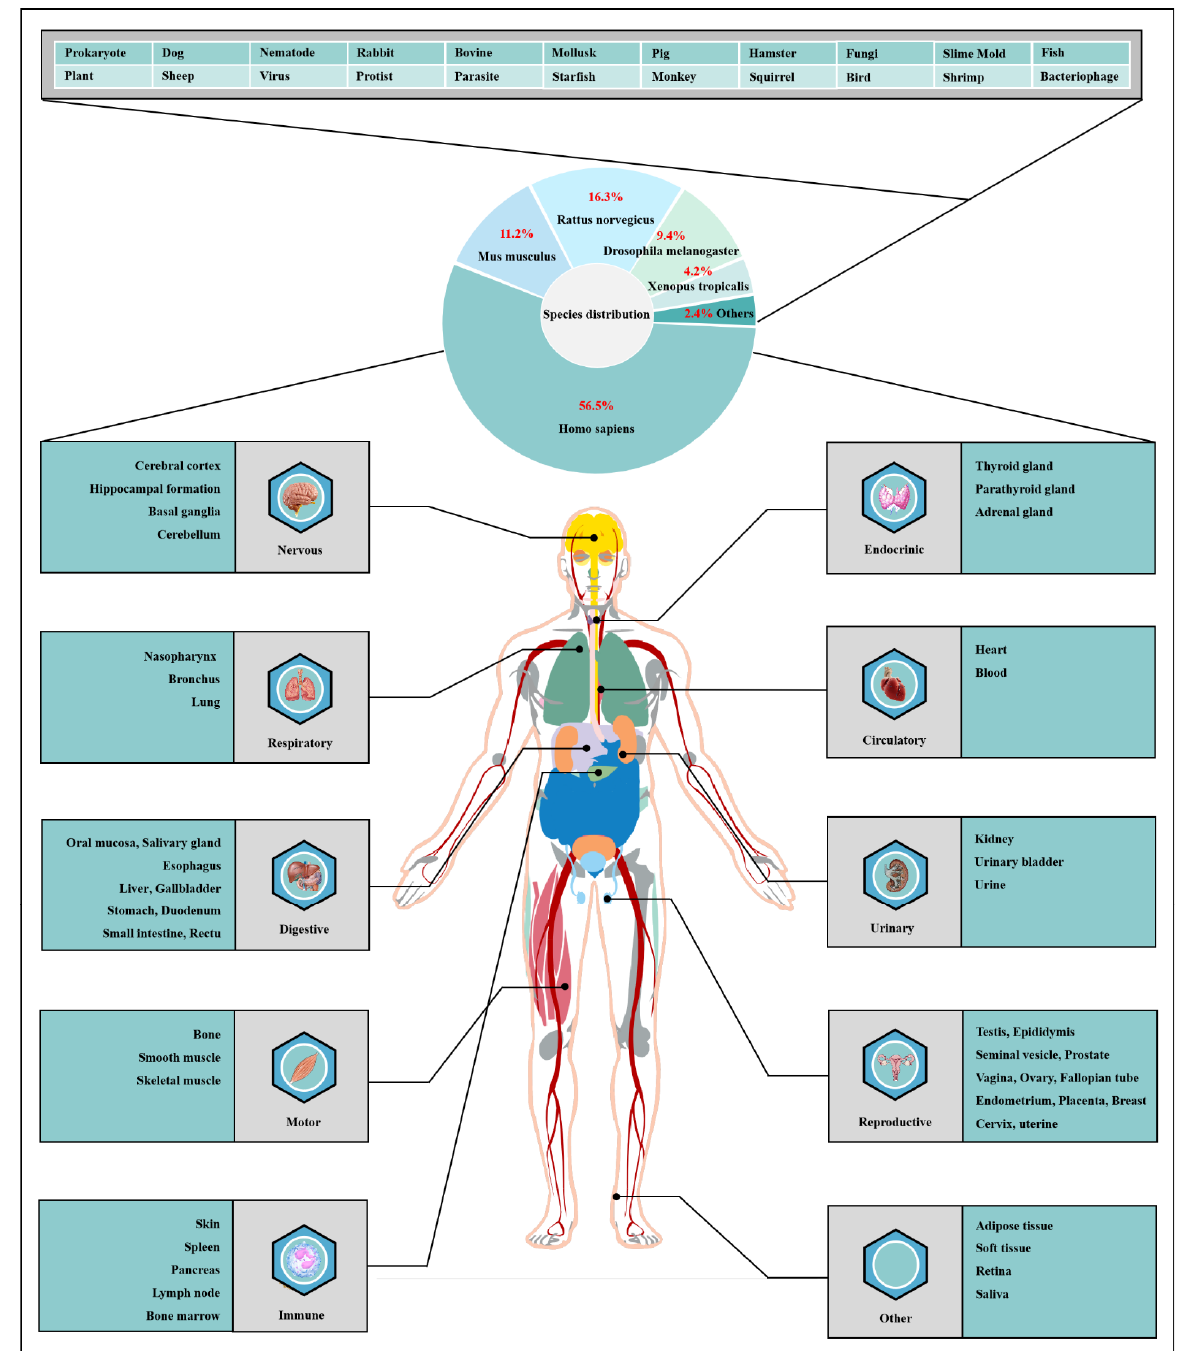
Figure 1. Species distribution of O -GlcNAcylation and its tissues’ distribution in Homo sapiens . The universality and conservation of O -GlcNAcylation is self-evident in filamentous fungi, worms, insects, plants and humans. There are more reports on the O -GlcNAcylation in human, mouse or rat, fruit fly and Caenorhabditis elegans species. However, O -GlcNAcylation has not been identified in yeast, and its similar role may be replaced by the O -mannosylation of nucleocytoplasmic proteins in yeast. O -Glcnacylation was found to occur in almost all major organs of Homo sapiens . This suggests that O -GlcNAcylation is essential for the survival of metazoans and is the root cause of the lethality of OGT and OGA knockout. Tissue distribution analysis emphasizes the strong characteristics of O -GlcNAcylationn in the brain and liver of Homo sapiens . Some organs or tissues with less distribution of O -GlcNAcylation may be limited by their own characteristics of less